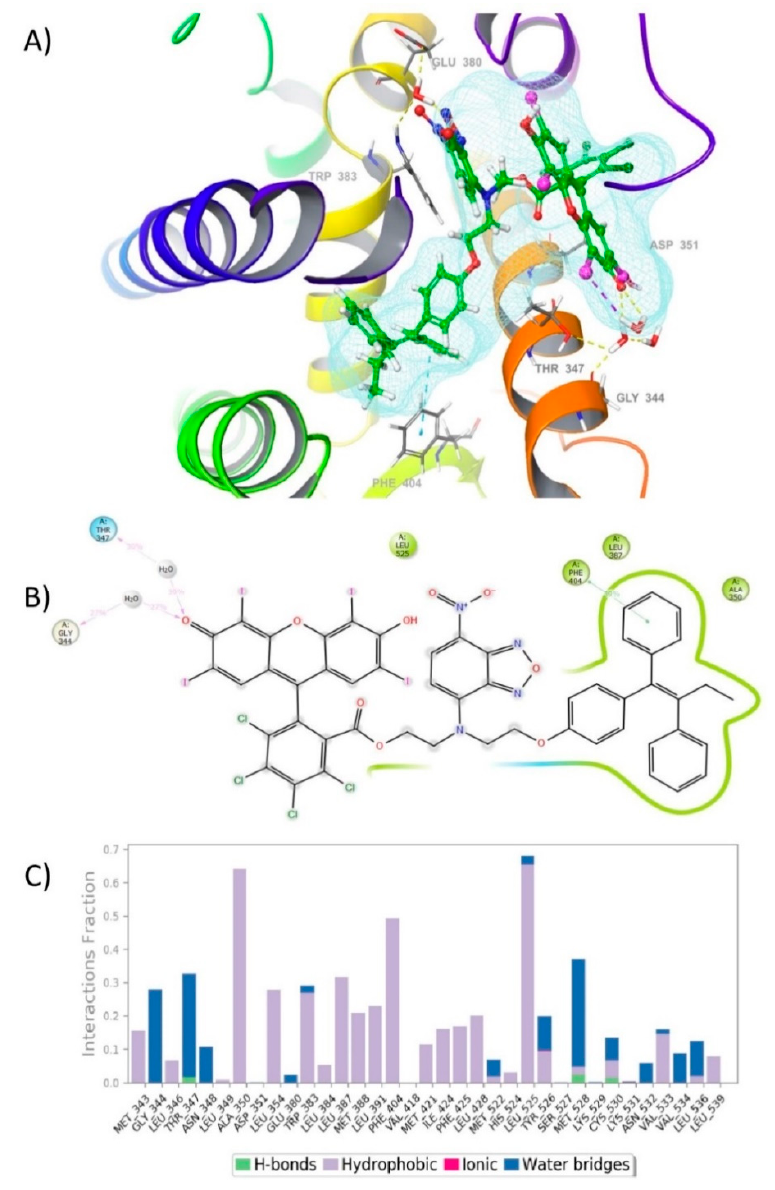
Figure 4. Molecular Dynamics study for FLTX2 on the human ER α ligand binding domain. ( A ) Interactions of FLTX2 with key amino acid residues at the hydrophobic binding pocket of human ER α LBD. ( B ) 2D Ligand-protein interaction diagrams and interaction strength quantified by the frequency of occurrences in the trajectory when a minimum percentage of 50% is achieved. Colors indicate type of residue: green are lipophilic residues; blue are polar residues; purple are basic residues. Ligand atoms that are exposed to the solvent are marked with grey spheres. ( C ) Stacked bar charts of human ER α LBD interaction with FLTX2 .